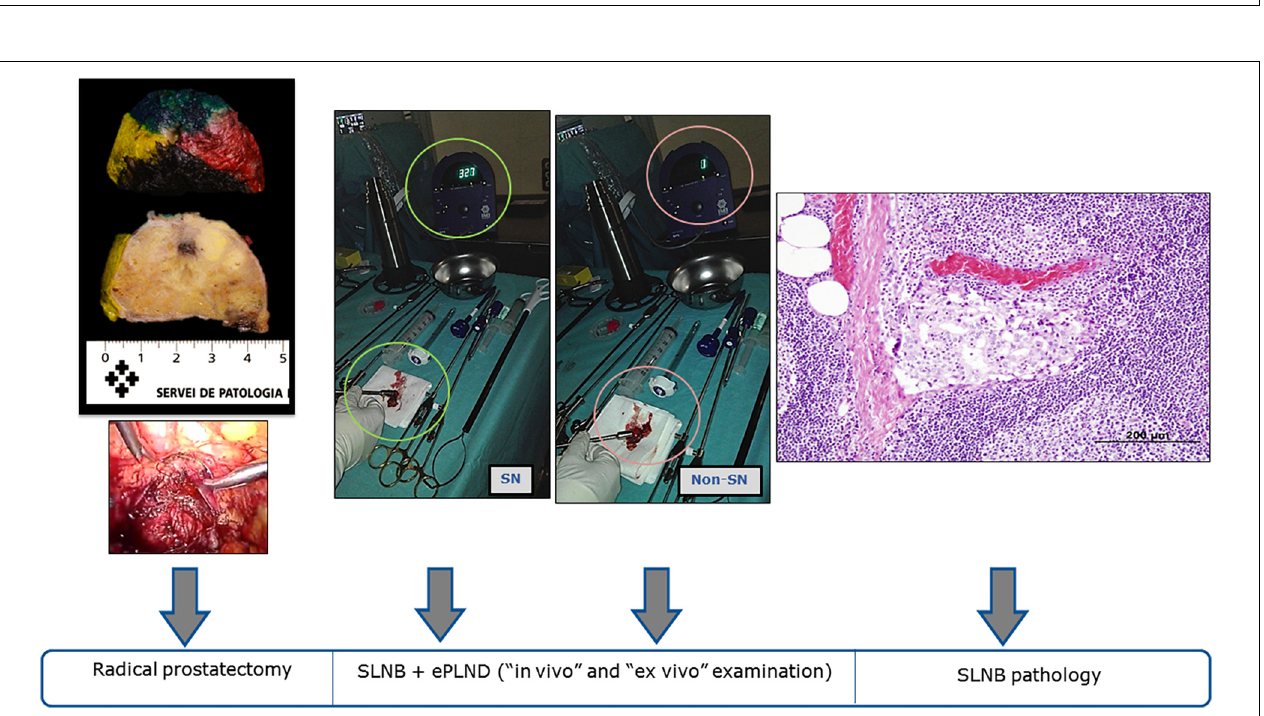
FIGURE 2 | Surgery, 2nd day: Laparoscopic radical prostatectomy, sentinel node detection, extended pelvic lymphadenectomy and ex vivo confirmation. Surgery, 2nd day: Laparoscopic radical prostatectomy, Sentinel Node detection (SLNB), extended pelvic lymphadenectomy (ePLND) and pathology results of the tissue removed. Prostatectomy specimen, formalin-fixed and perpendicularly sectioned from apex to base. The index tumor lesion is located in the left lobe. Microscopic image of a SLN section showing a subcapsular metastasis of acinar prostatic adenocarcinoma (Hematoxylin-Eosin, 100x).